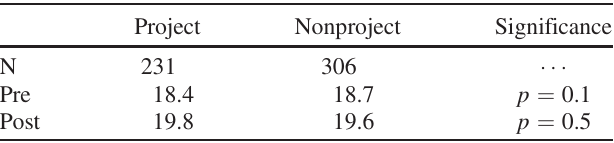
TABLE VI. Overall E-CLASS scores (points) for students in courses that included multiweek projects and those that did not. Consistent with the courses that include projects, all courses represented here are BFY courses that are self-classified as including open-ended activities. Significance indicates the stat- istical significance of the difference between students ’ scores in the project and nonproject